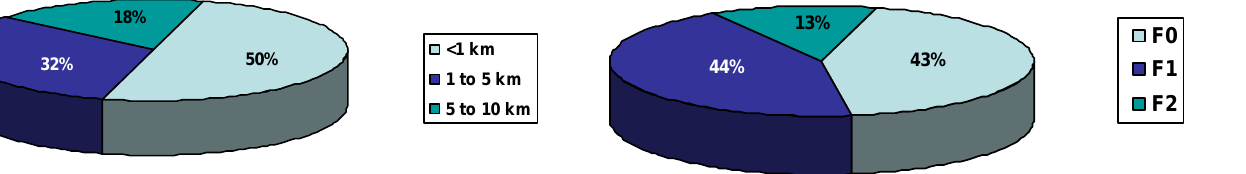
Fig. 12. Distribution of tornadoes recorded in Catalonia (1950– 2005) following the Fujita Figure 12. Distribution of tornadoes recorded in Catalonia (1950-2005) following the Fujita scale.